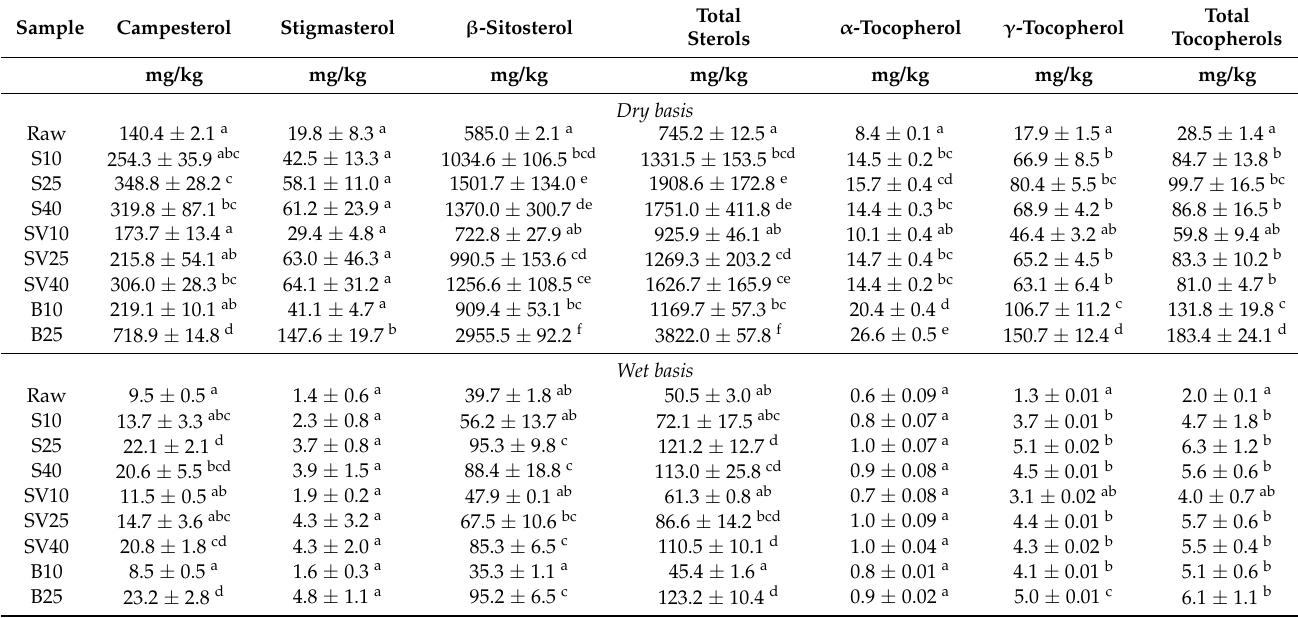
S10, S25, and S40 indicate 10, 25, and 40 min of exposure to steaming in the saturated oven; SV10, SV25, and SV40 indicate 10, 25, and 40 min of exposure to sous-vide in the saturated oven; B10 and B25 indicate 10 and 25 min of exposure to boiling in the hot water. Different letters within columns indicate significant differences (Tukey’s test, p <